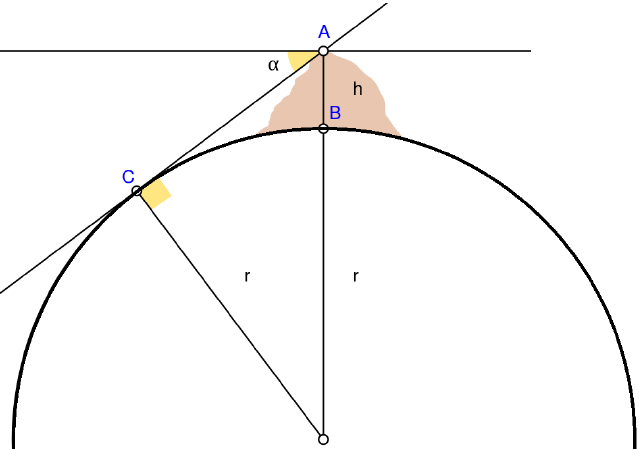
Figure 3. The measurement of Earth’s radius using the Al-Biruni